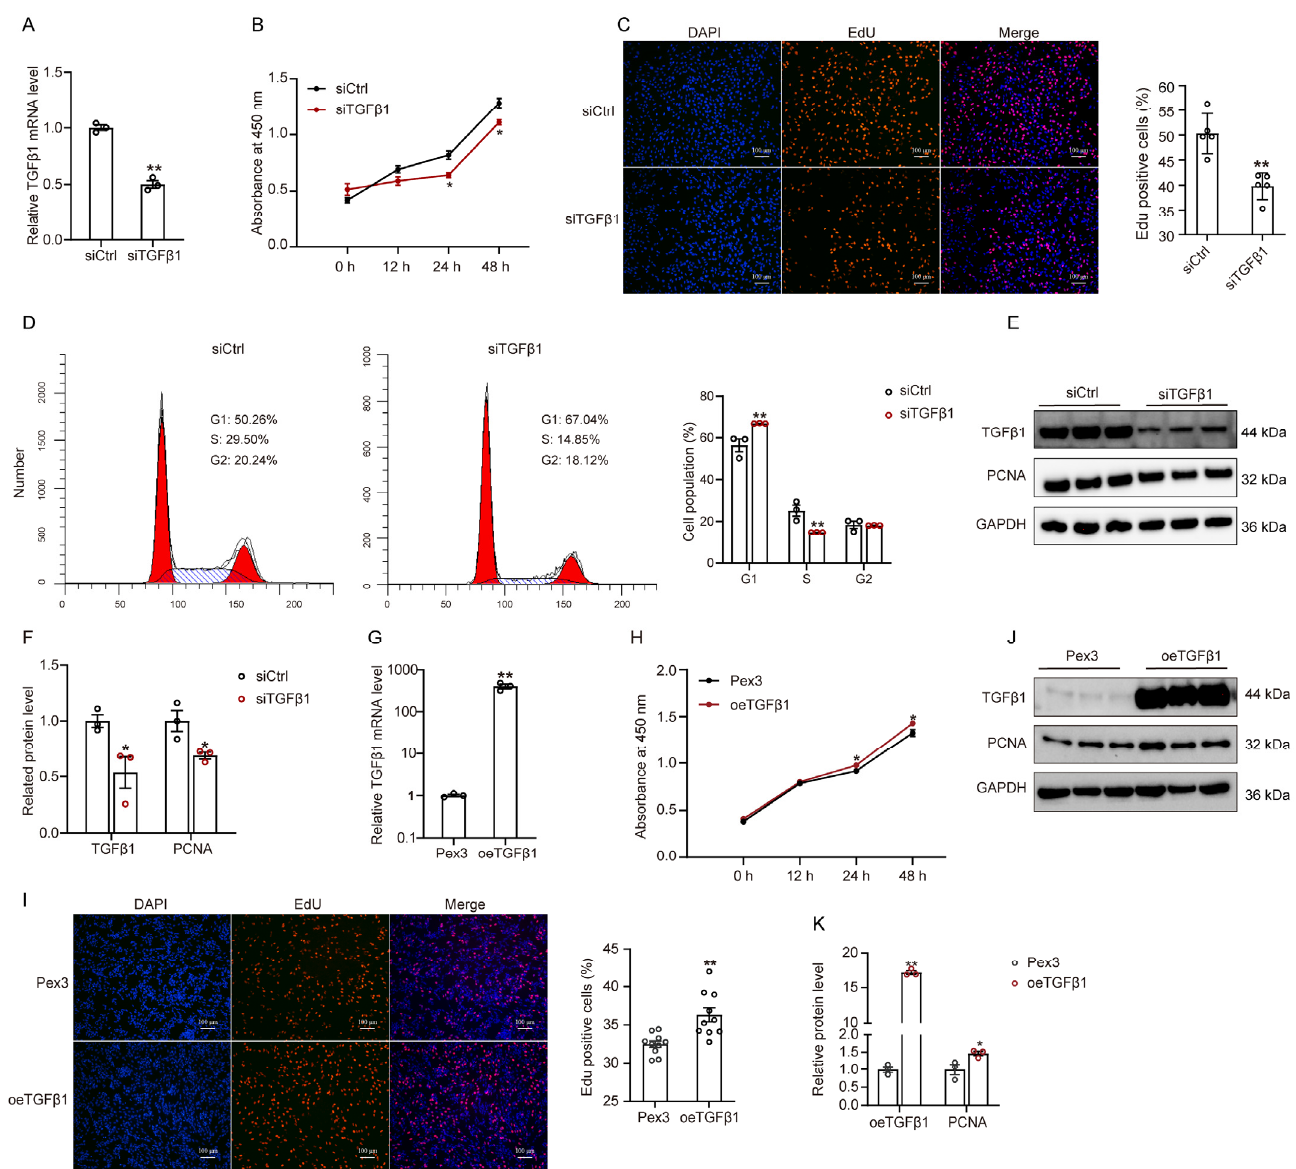
Figure 2. TGF β 1 promotes myoblast proliferation: ( A – K ) GPMs were transfected with control siRNA (siCtrl) or TGF β 1 siRNA (siTGF β 1), as well as overexpression TGF β 1 plasmid (oeTGF β 1) or empty pEX-3 vector (Pex3); ( A , G ) The TGF β 1 mRNA expression level was measured at 36 h post- transfection; ( B , H ) The viability of GPMs was detected by using CCK8 assay; ( C , I ) After transfection for 36 h, the cells were stained with EdU. Representative images were shown (left), scale bar, 100 µ m. Quantification of the percentage of EdU-positive cells (right); ( D ) Flow cytometry analysis of cell cycle progression of cells (left), and the percentage of cells in each phase of the cell cycle was quantified; ( E , J ) Western blot analysis of the protein level of TGF β 1 and PCNA in cells; ( F , K ) Quantification of the Western blot results of ( E , J ). The data were obtained from at least three independent experiments. Results are expressed as mean ±SEM; * p < 0.05, ** p < 0.01.